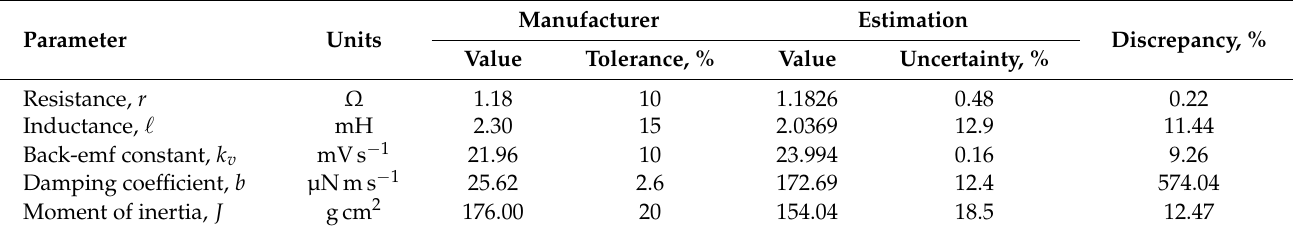
Table 4. Parameters provided by the manufacturer and estimated through